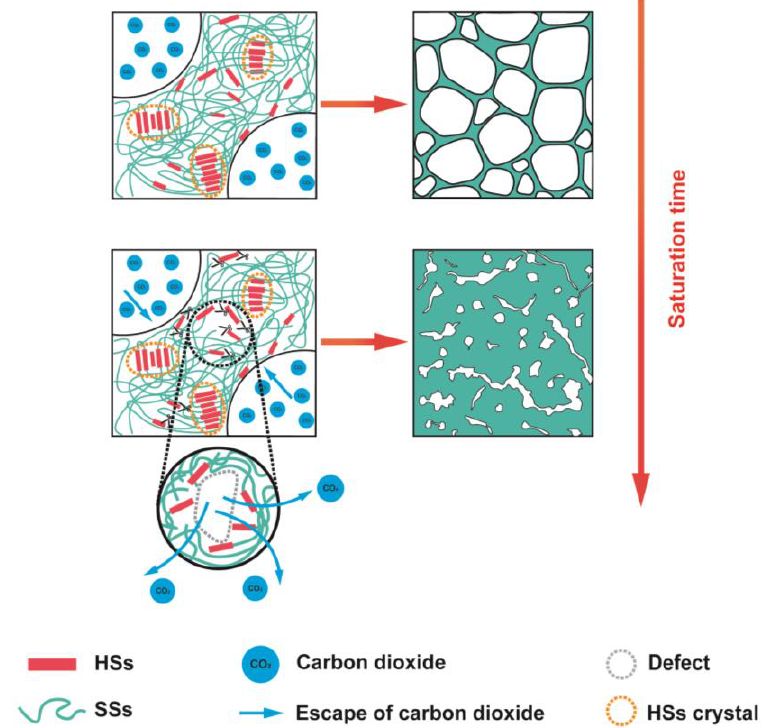
Figure 13. The mechanism of restricted expansion of HD-TPU foams.